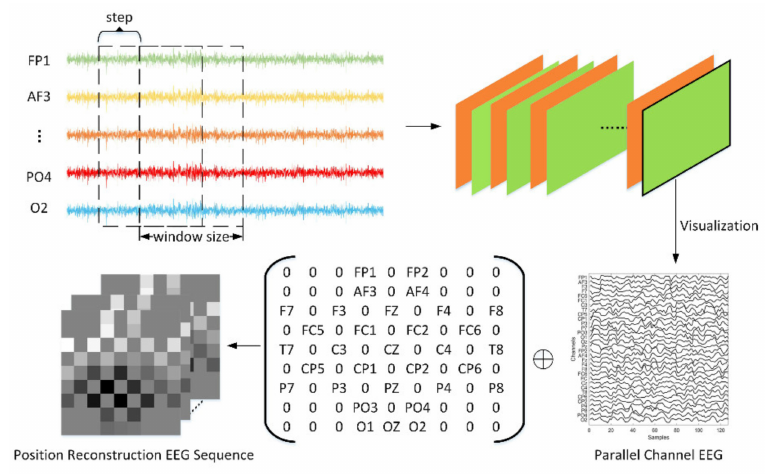
Figure 4. The construction process of two EEG representations. Parallel channel EEG is obtained through a sliding window, and then superimposed with the position projection to convert it to Position Reconstructed EEG sequence.